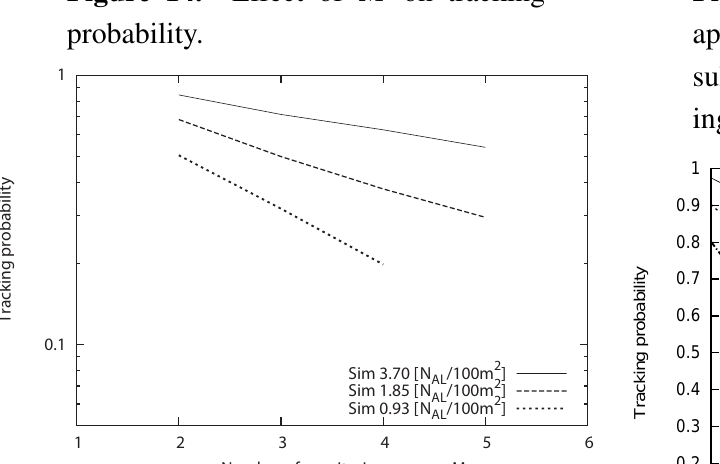
Figure 14. Effect of M on tracking probability.